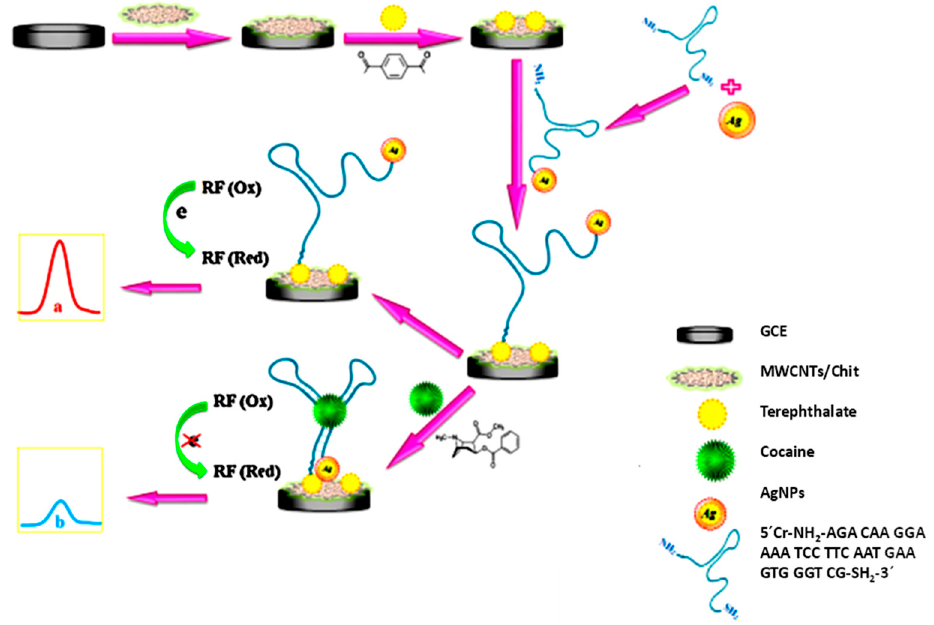
Figure 3. Schematic display of the preparation steps and functioning of the aptasensor constructed for cocaine detection. Reproduced from [52], with